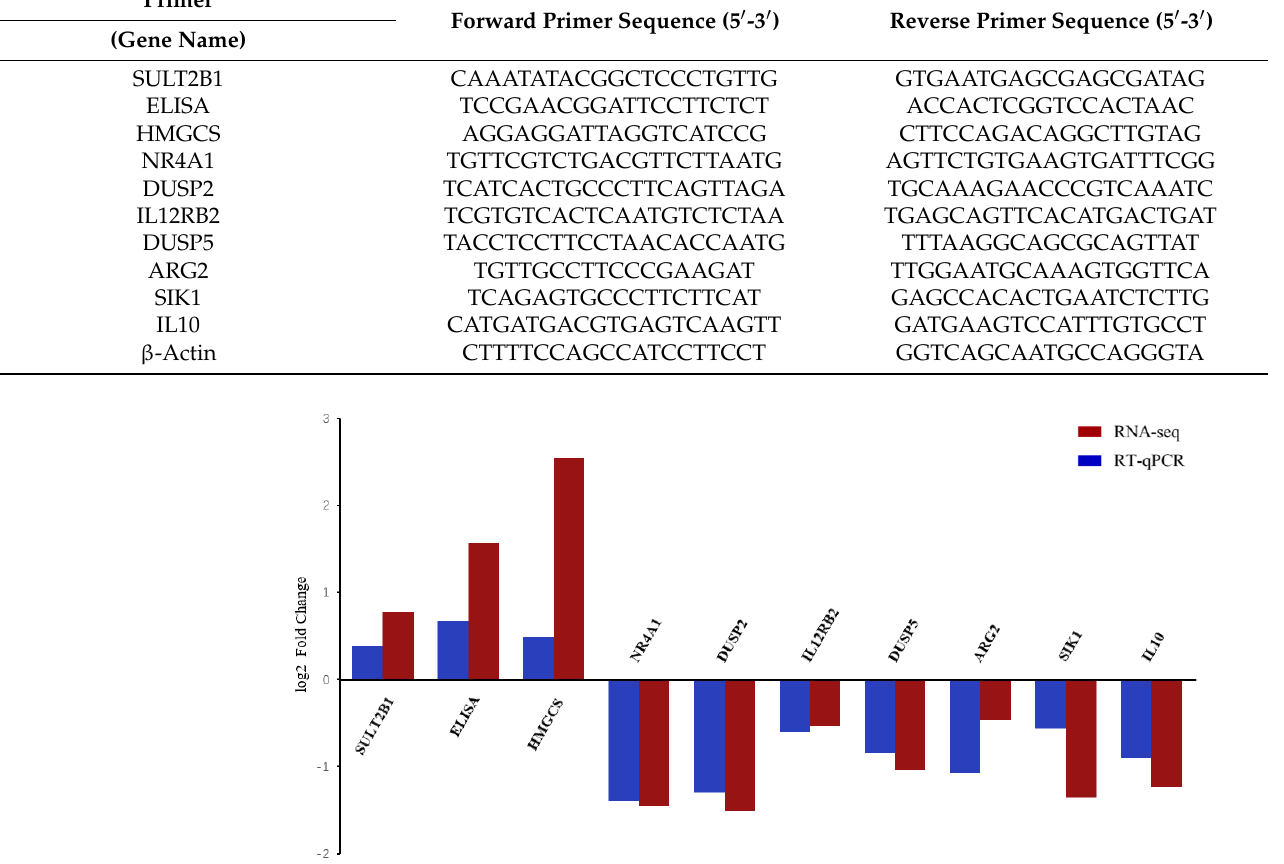
Figure 6. Gene expression analysis using qRT-PCR and RNA-seq for comparison. The X -axis shows the gene names, and the Y -axis shows the log2 values of the relative gene expression between the two groups. Log2 values of relative gene expression between the two groups were calculated using qRT − PCR (blue column) and RNA − seq (red column), respectively.